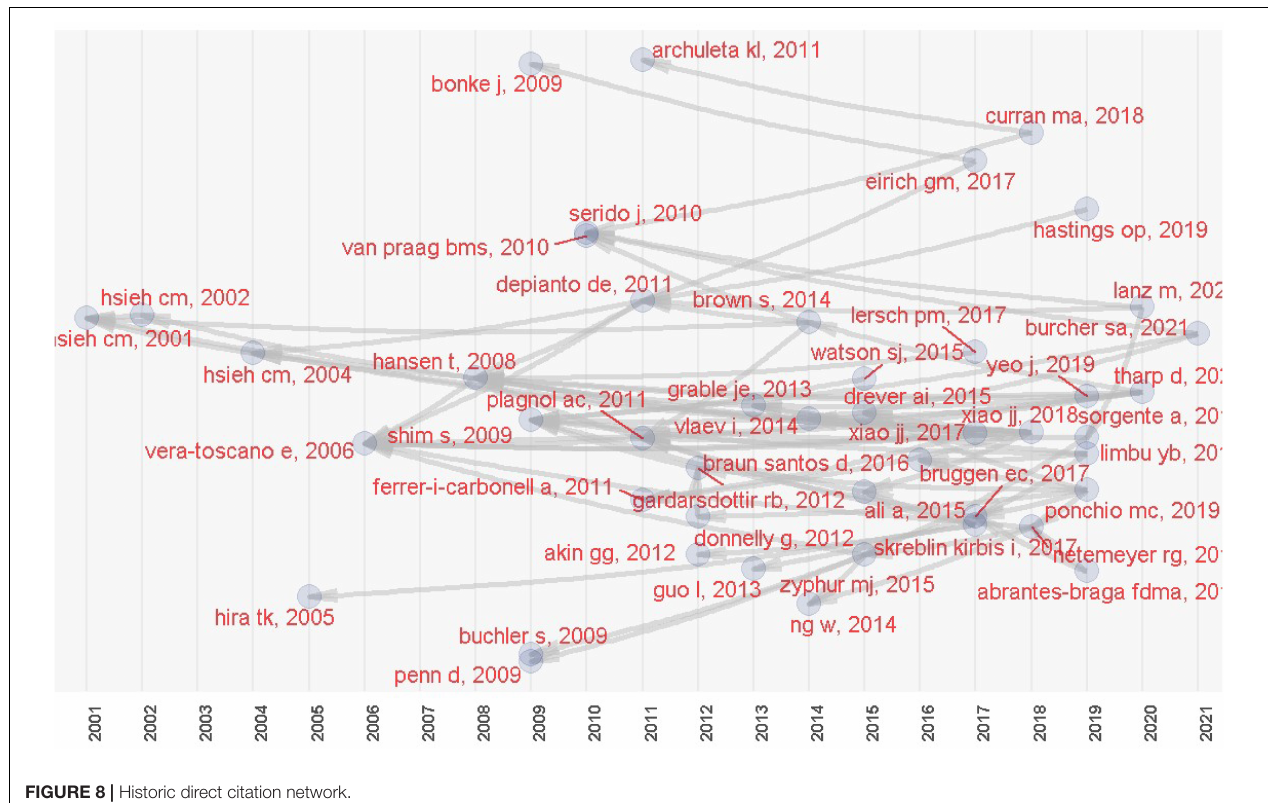
FIGURE 8 | Historic direct citation network. TABLE 3 | Most productive countries and total citations per